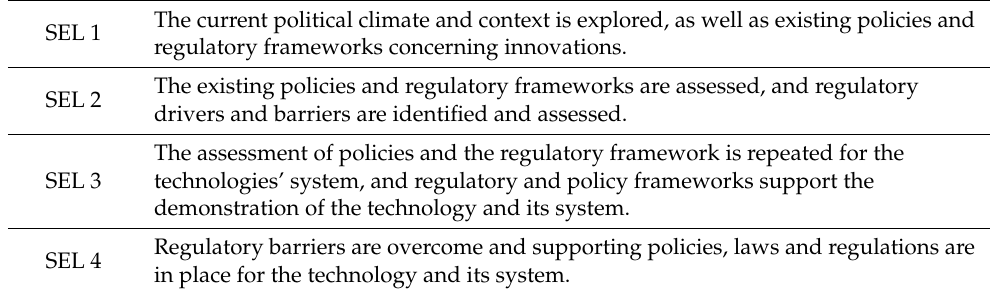
Table 6. Dimension 3: policy and